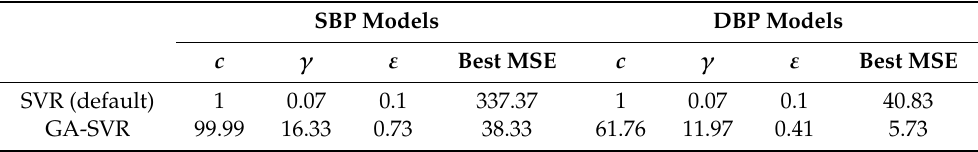
Table 1. Parameters of SBP and DBP models using support vector regression (SVR) and comparison between before and after GA optimization, the best mean squared error (Best MSE) represented the model accuracies.